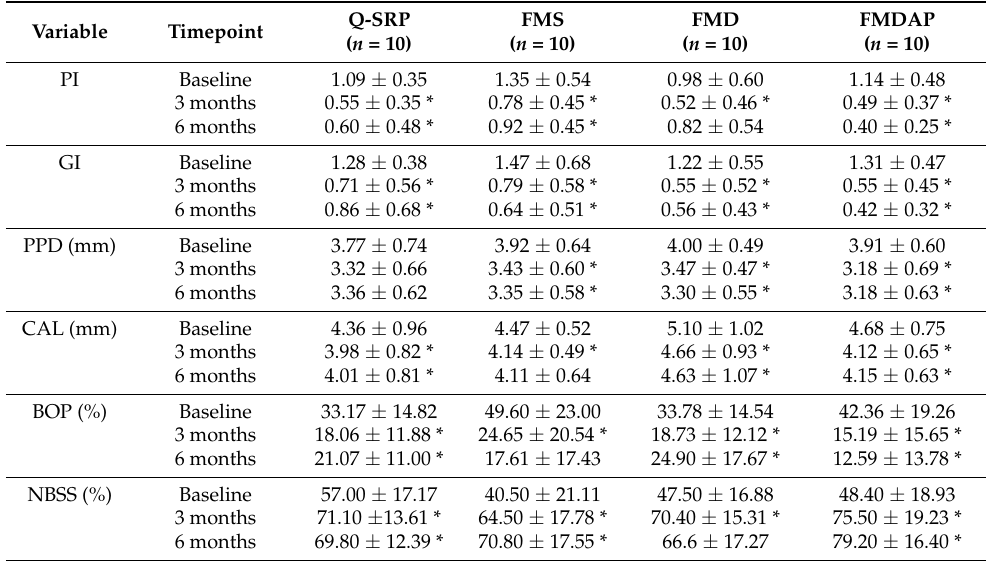
Table 2. Full-mouth clinical parameters at baseline and follow-up